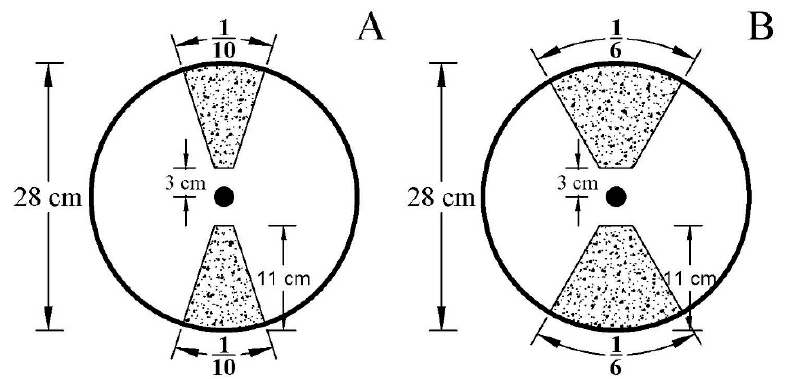
Figure 7. Root pruning method of small root pruning ( A ) and large root pruning ( B ). The root system was cut off vertically from the soil surface to the bottom along the two sides, approximately 3 cm away from the plant using a 28 cm single-sided knife at the jointing stage.